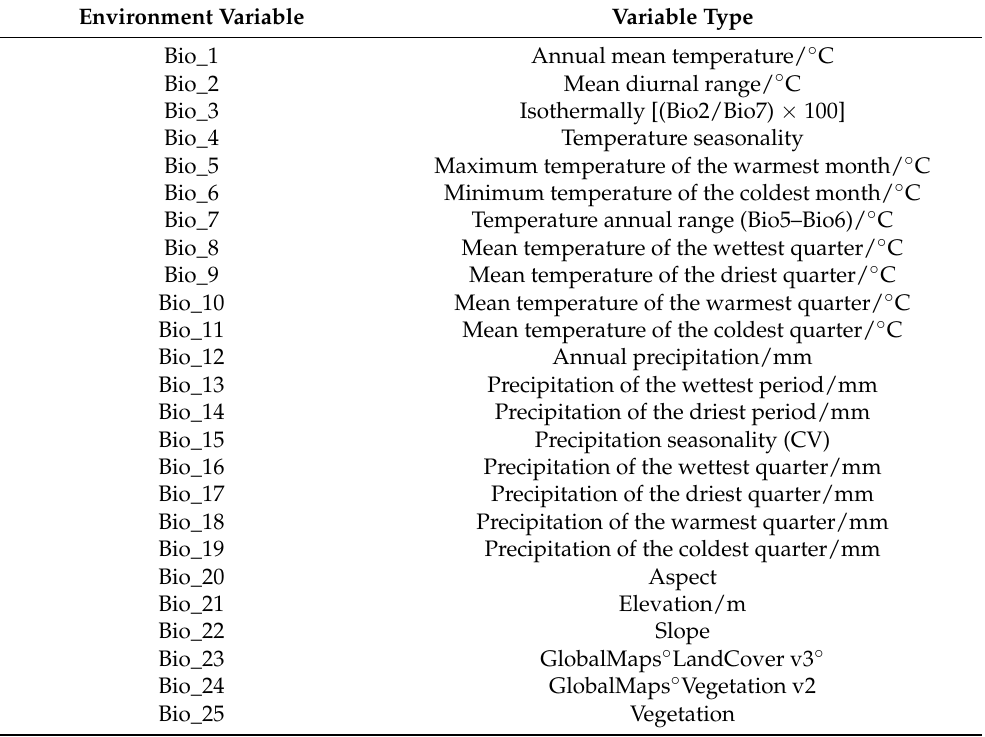
Table 1. Environment variables for MaxEnt